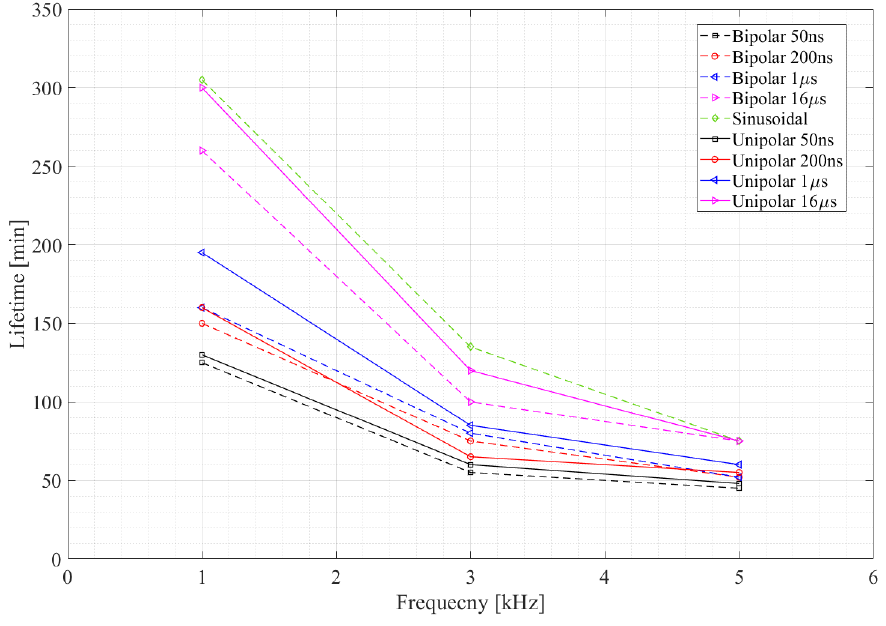
Figure 9. Relationship between lifetime values and different voltage frequencies; figure extrapolated from experimental data of the work conducted by Wang et al.